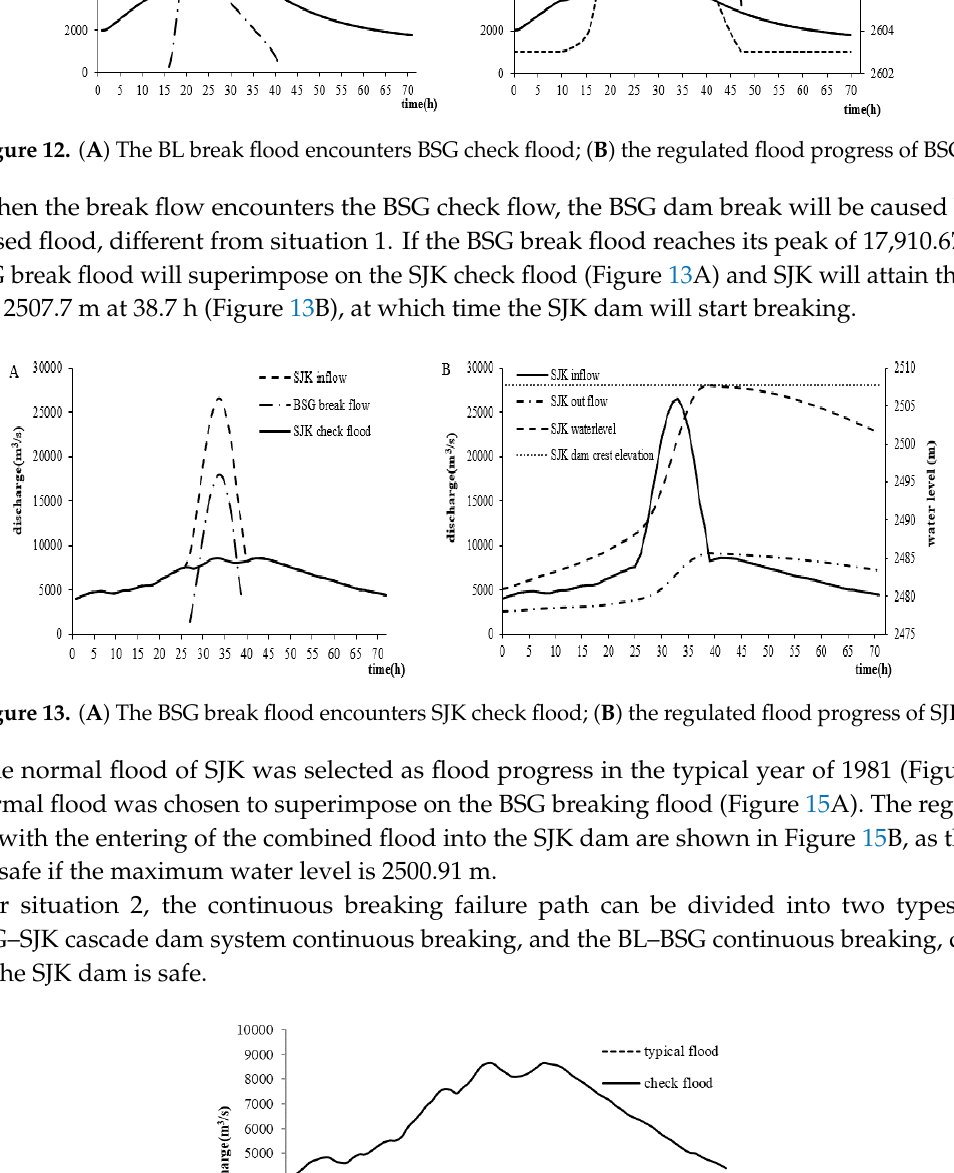
Figure 15. ( A ) The BSG break flood encounters SJK normal flood; ( B ) the regulated flood progress of SJK. For situation 2, the continuous breaking failure path can be divided into two types: The BL–BSG–SJK cascade dam system continuous breaking, and the BL–BSG continuous breaking, during which the SJK dam is safe. 4.2.3. Dam Continuous Breaking Analysis for Situation 3 As for situation 3, the BL breaking flood is composed of BSG typical flood (the typical year in 1981), which enables the BSG dam to attain the dam crest of 2608 m at 19.1 h (Figure 16B), at which time the BSG dam begins to break. In addition, the peak of the BSG breaking flood is 16,681.53 m 3 /s (Figure 17A), at which time the BSG breaking flood is superimposed on the SJK typical flood. After being regulated by SJK (Figure 17B), the SJK dam is safe if the maximum water level reaches 2496.57 m. Figure 16. ( A ) The BL break flood encounters BSG typical flood; ( B ) the regulated flood progress of BGS.